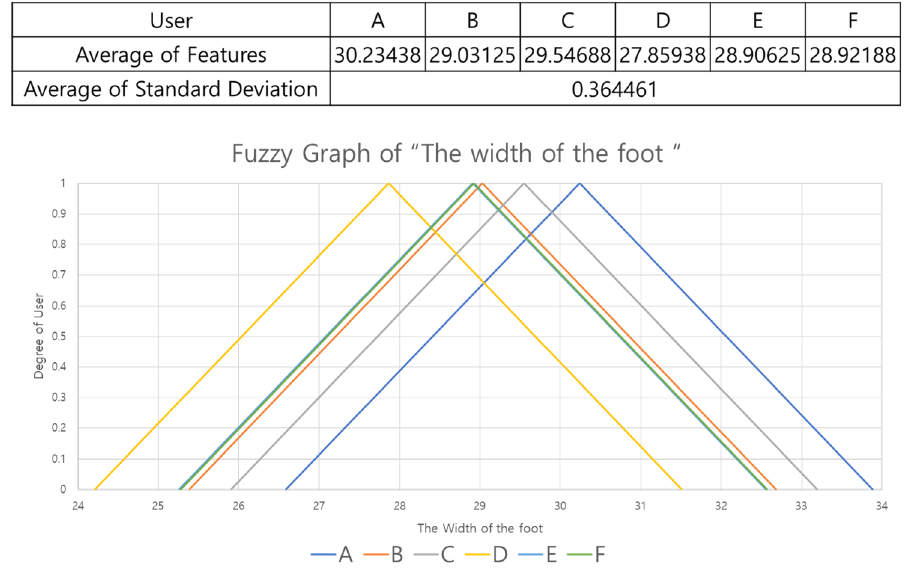
Figure 15. Fuzzy graph of the ‘width of foot’ feature.